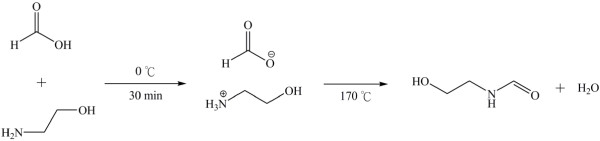
The synthesis of ionic liquid of 2-hydroxyenthanaminimium formate and the thermal transformation.